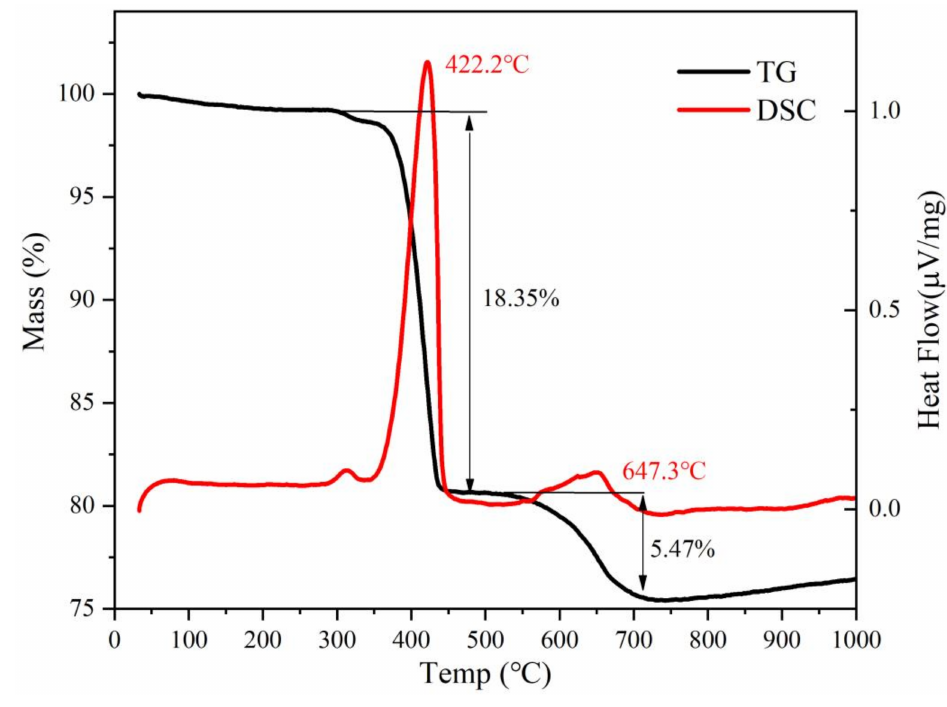
Figure 2. TG-DSC curves of raw quicklime.